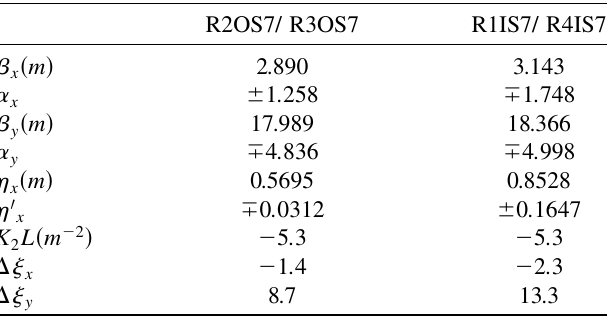
GENERAL CONDITIONS FOR SELF-CANCELLATION OF . . TABLE II. The Twiss functions at R2OS7/R3OS7 and R1IS7/ R4IS7 of BEPCII lattice for the positron ring. The phase advance in both x and y planes between the two sextupoles in each pair is 3 (cid:5) .